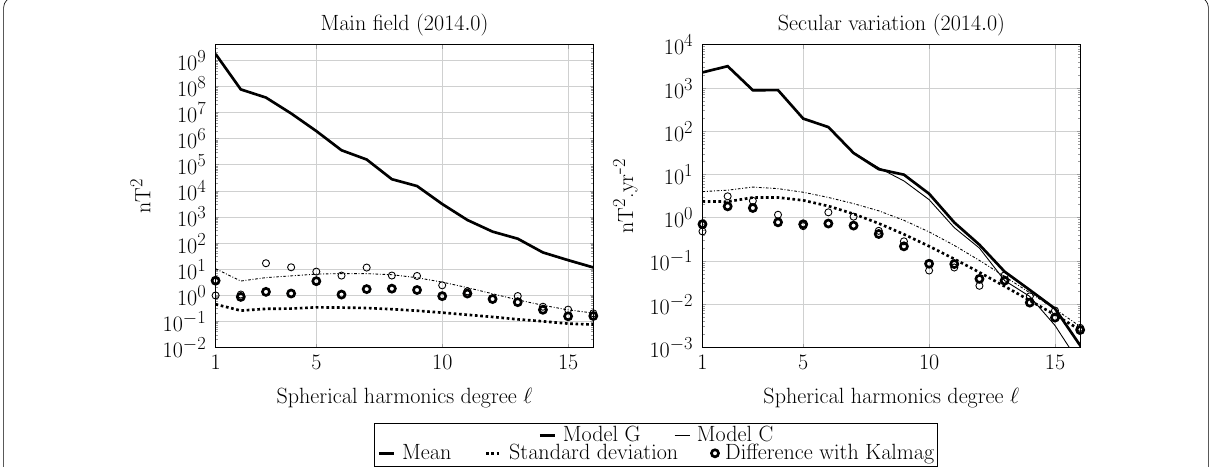
Fig. 13 Main field (left) and secular variation (right) energy spectra at the Earth’s surface in 2014.0. Spectra of the mean (solid lines), standard deviation (dashed lines) and difference with the Kalmag model (circles) for model G (thick lines and symbols) and model C (thin lines and